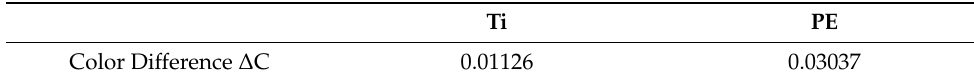
Table 2. Color difference between titanium and PE specimens.